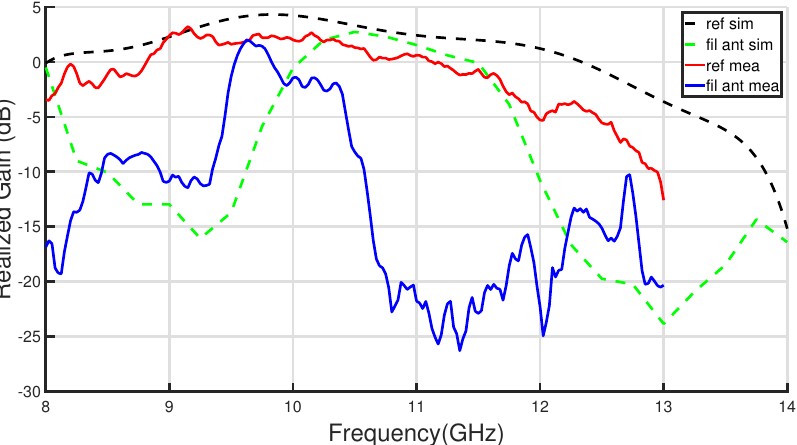
Figure 20. Comparison of measured and simulated broadside gain frequency response between the proposed IM-GWG filtering antenna and the reference slot